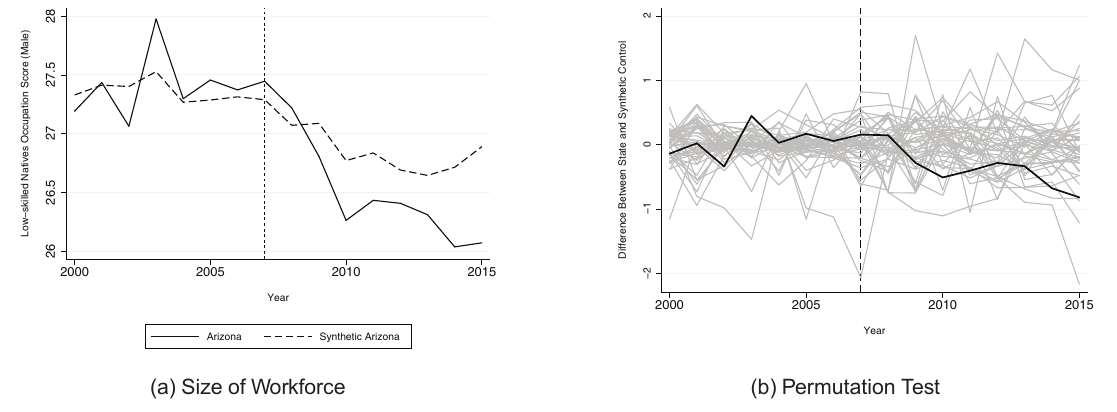
Figure A29 Low-skilled natives occupational income score (male)